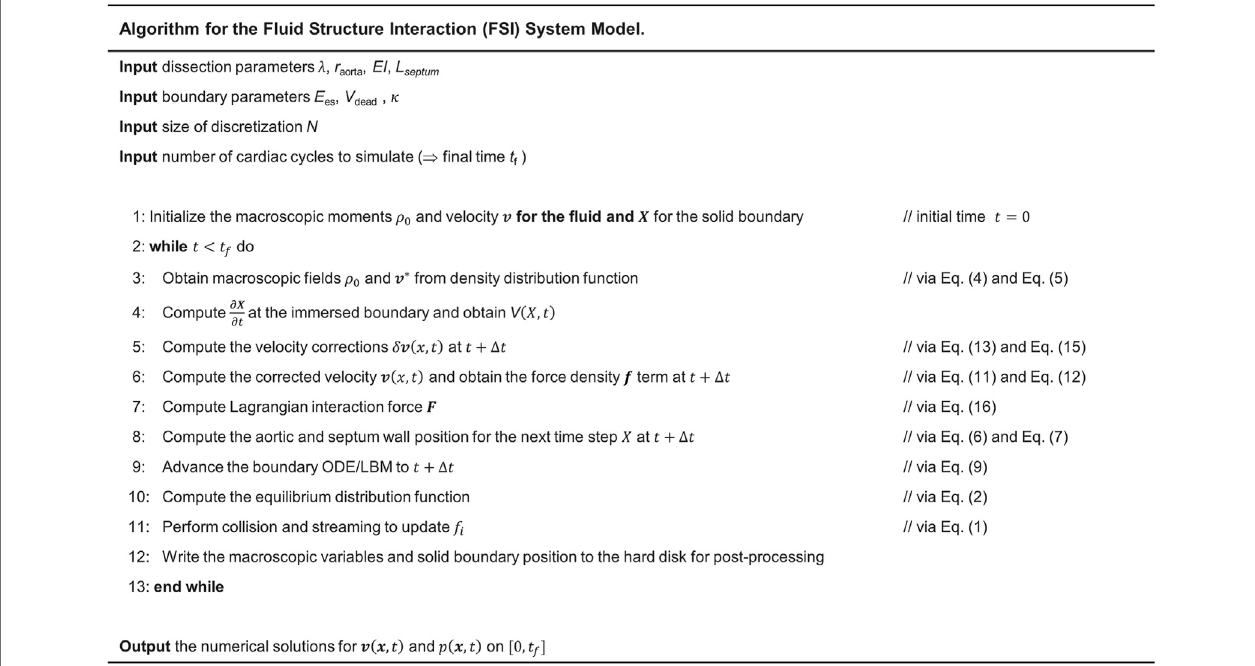
FIGURE 4 | Steps for implementation of IB-LBM-FEM algorithm to numerically solve the LV-Dissection system model with time-varying elastance LV input.